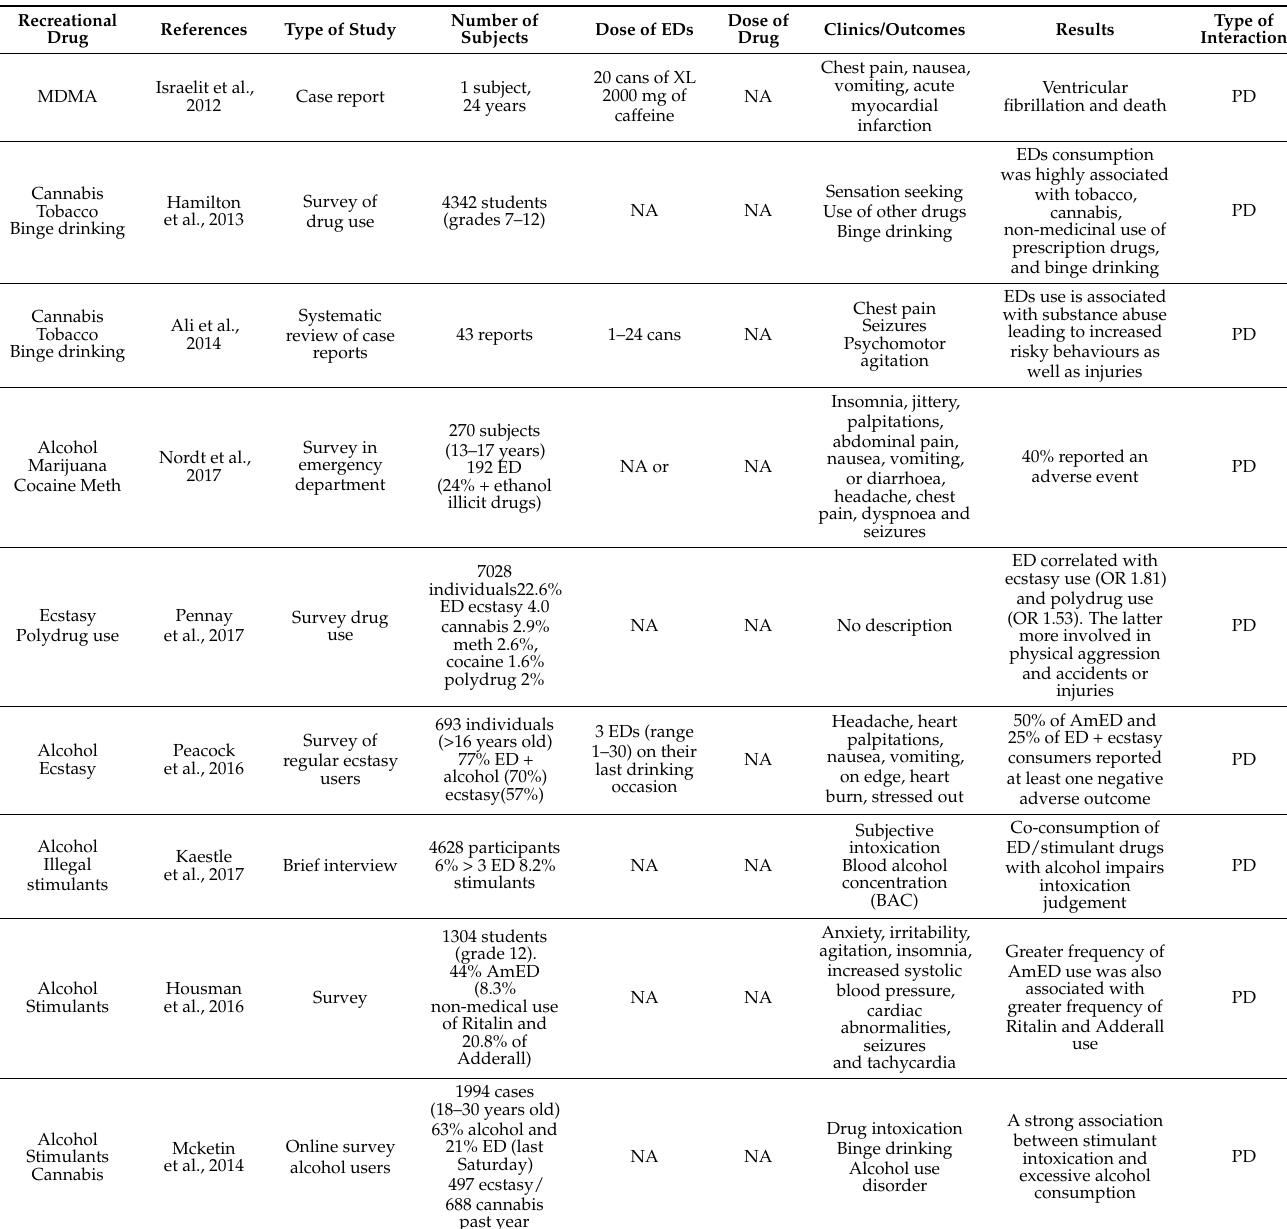
Table 4. Intoxications and surveys reporting use of EDs with other